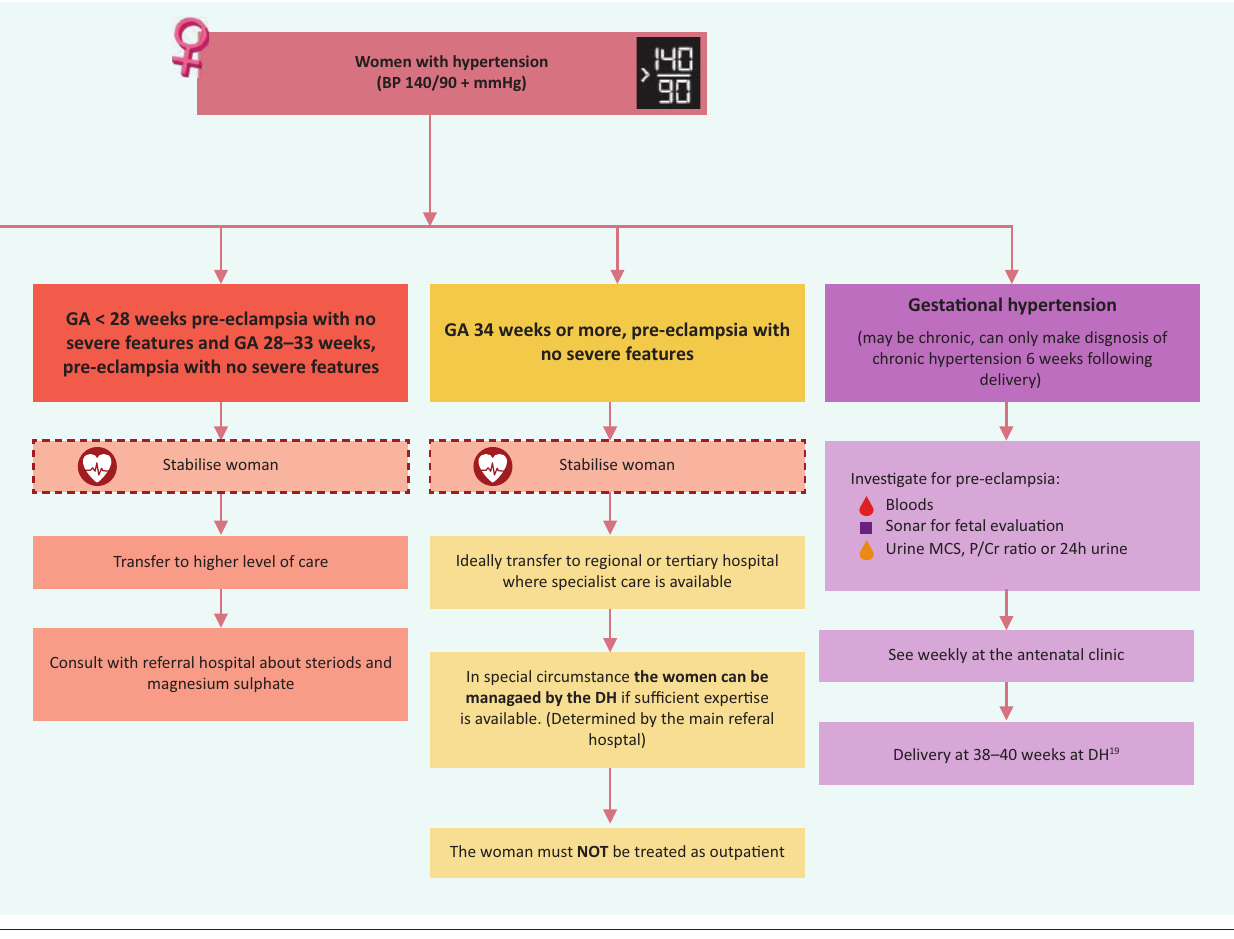
FIGURE 3: Management of patients with hypertensive disorders in pregnancy according to gestational age.